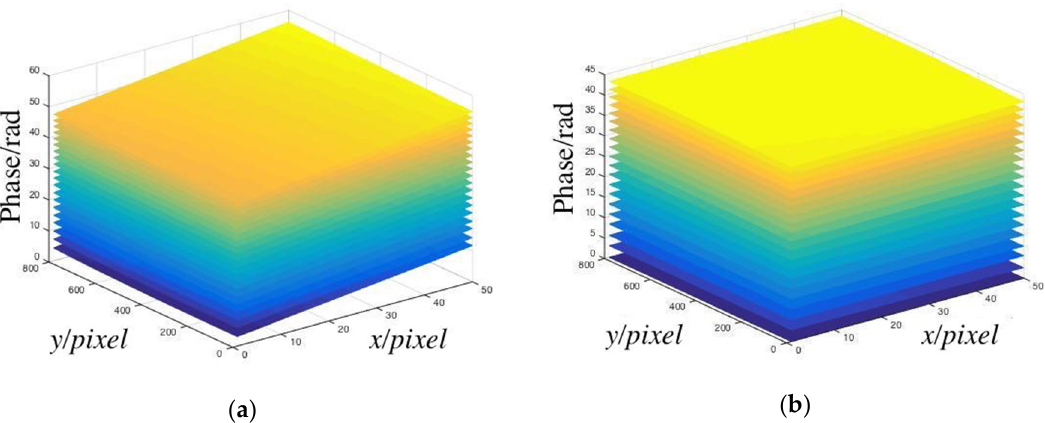
Figure 3. ( a ) Phases of calibration planes; ( b ) relative phases of calibration planes.